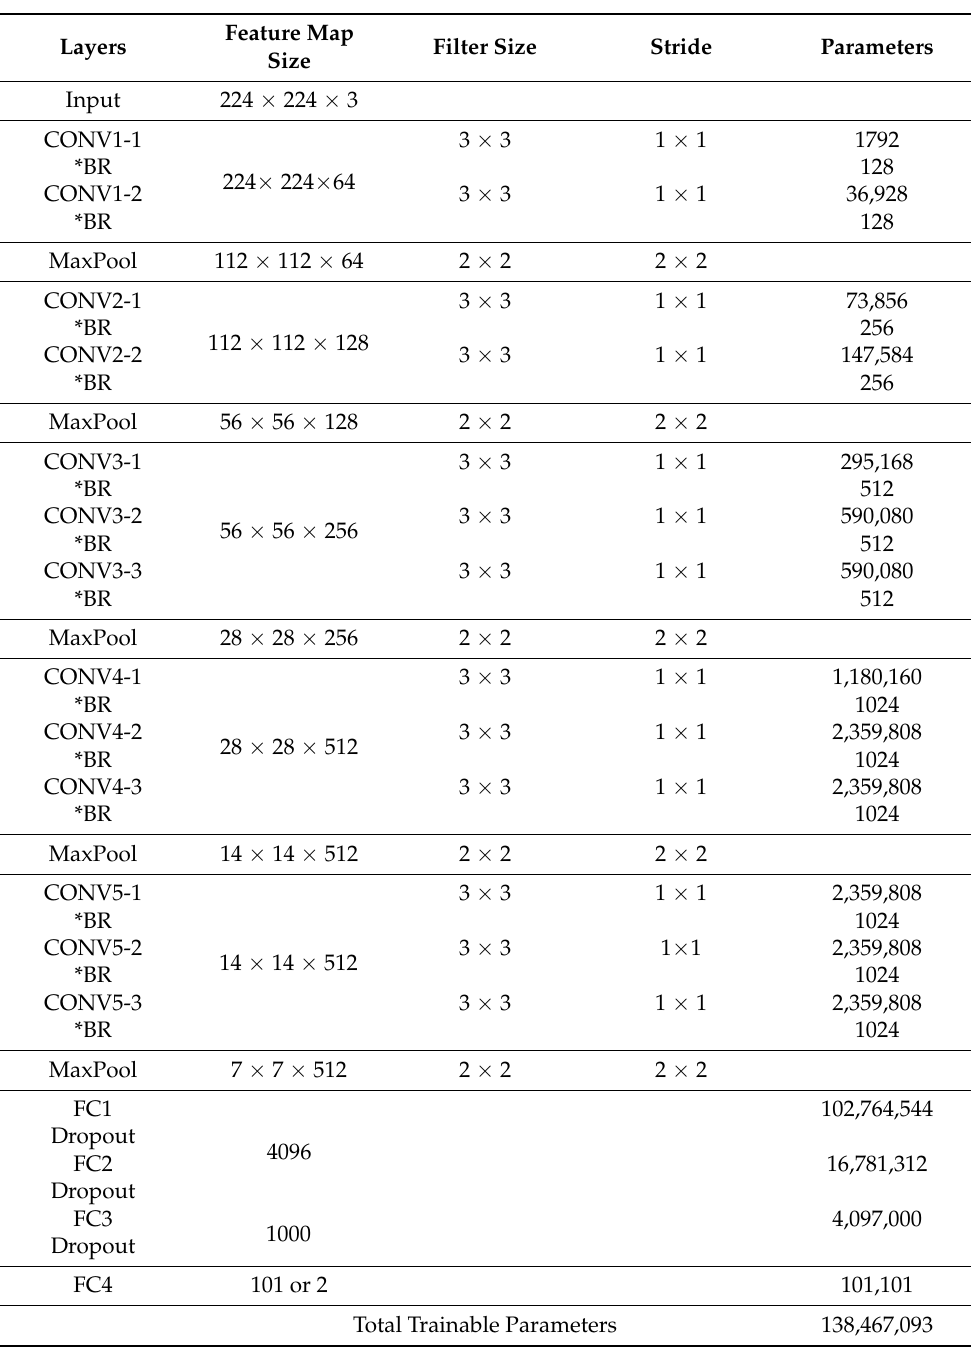
Table 2. The details of our age and gender estimation